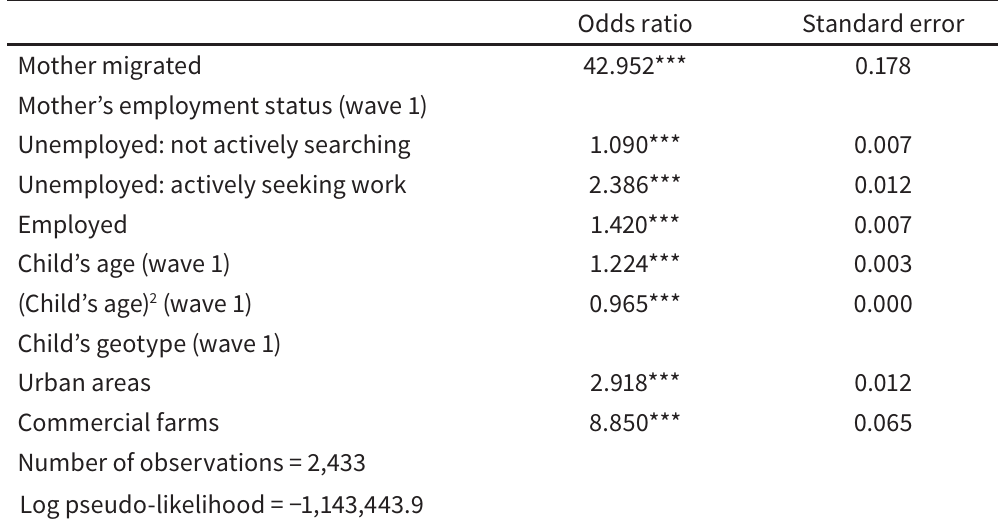
Likelihood of child migration by mother’s migration and employment status Odds